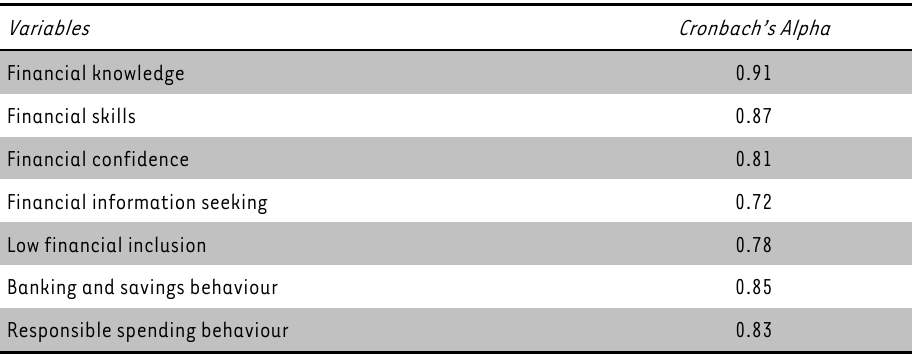
Inter-item correlation and reliability of the measuring instrument